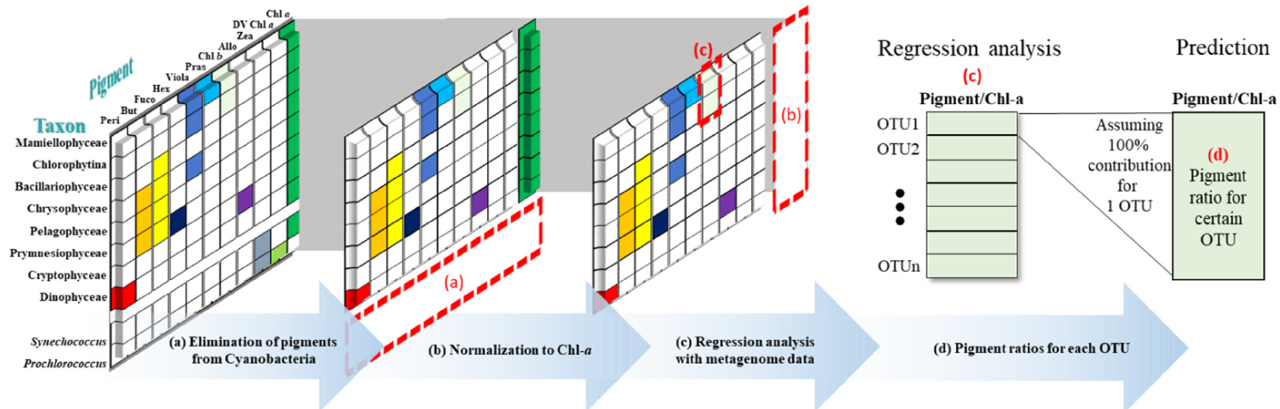
Figure 2. Diagram of pigment ratio modeling. To construct a linear model that related pigment concentrations to DNA sequence composition data, preprocessing was conducted to eliminate pigments from Cyanobacteria (a) and normalize to Chl- a (b). Then, the linear model was constructed (c) using the non-negative least squares method [41], and the range for each pigment ratio was determined from 95% prediction intervals (d).